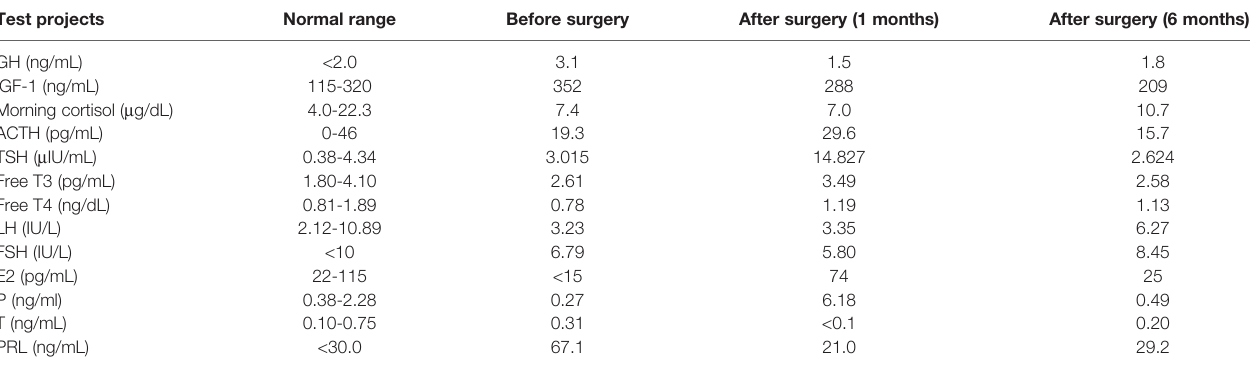
TABLE 1 | The results of the pituitary hormone test in our case. Test projects Normal